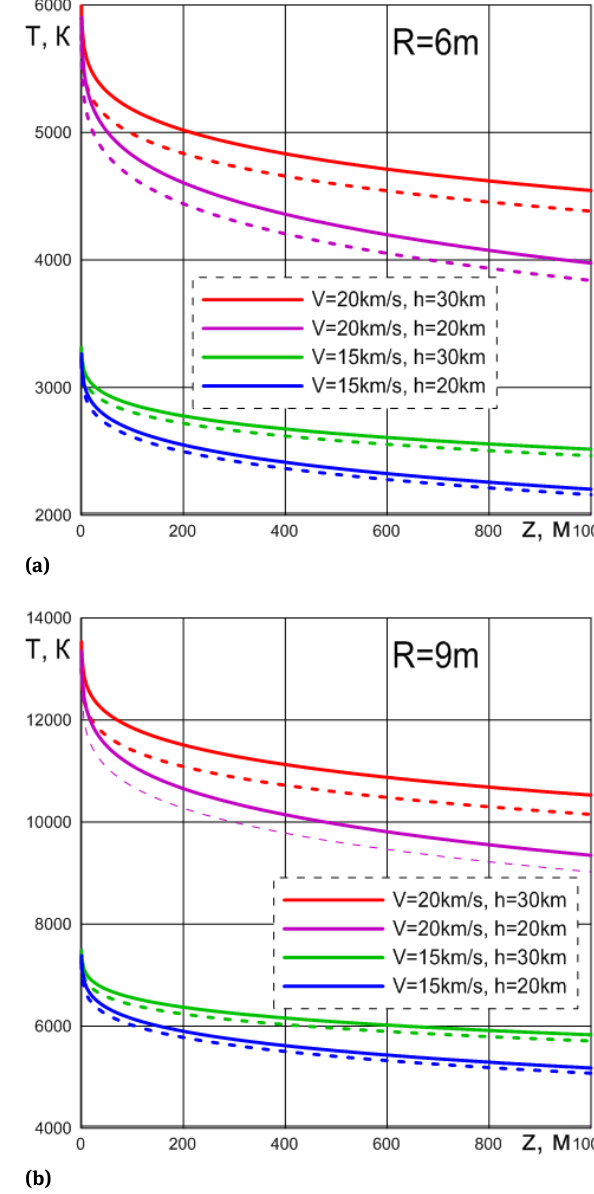
Figure 1. The temperature in a cloud of gas and vapor for a meteor body of radius (a) 9 m and (b) 6 m. The velocity at the moment of fragmentation is 20 m/s (red and purple lines) and 15 km/s (green and blue lines). Red and green curves related to distraction at al- titude of 30 km. Blue and purple lines related to 20 km. Solid line referred to model taking into account ablation and dashed ones to model without ablation of